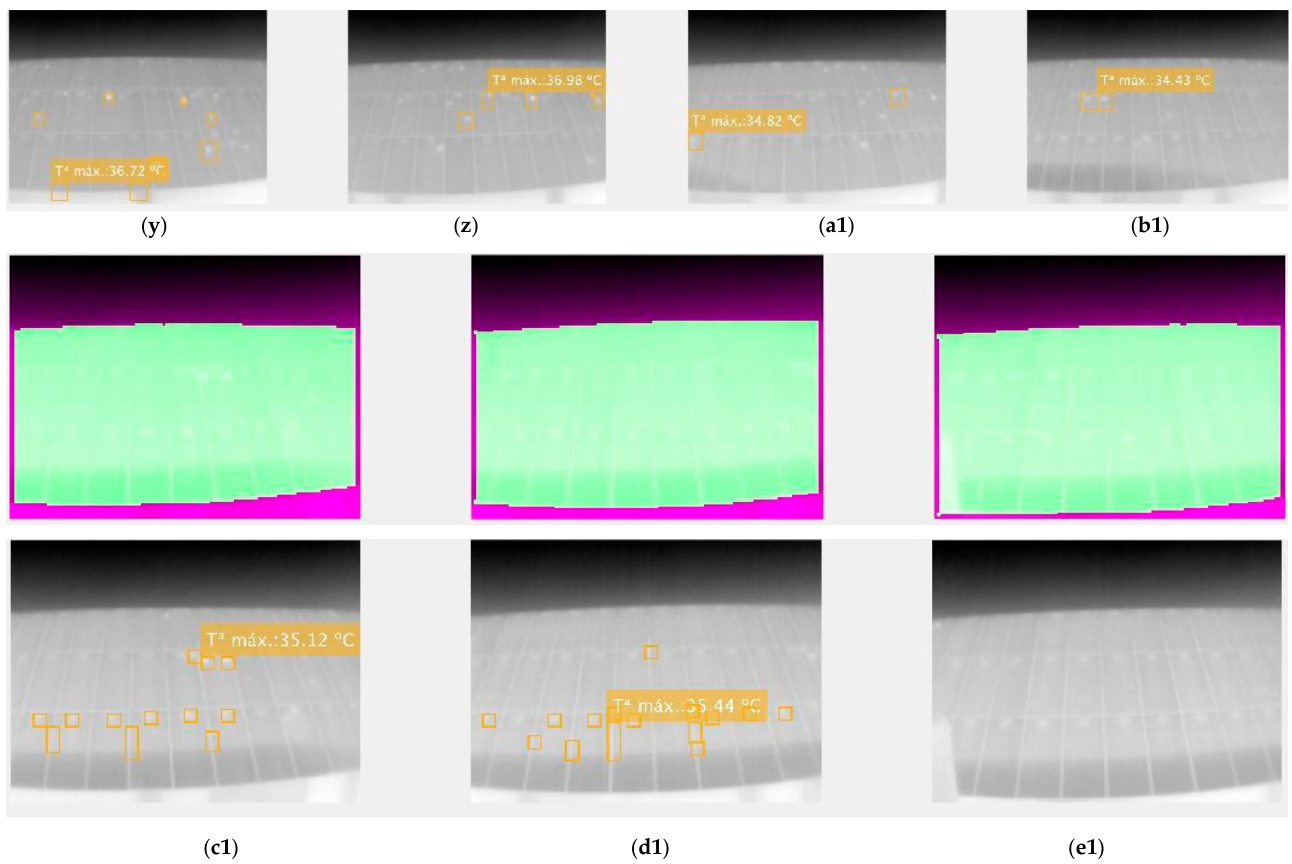
Figure A1. Images resulting from hot spot segmentation and labeling. Figures A1( a – p ) correspond to the thermographs taken at 16:00h (irradiance of 312.6 W/m 2 ). Figures A1( q – e1 ) correspond to those taken at 19:00h (irradiance of 2.81 W/m 2 ).